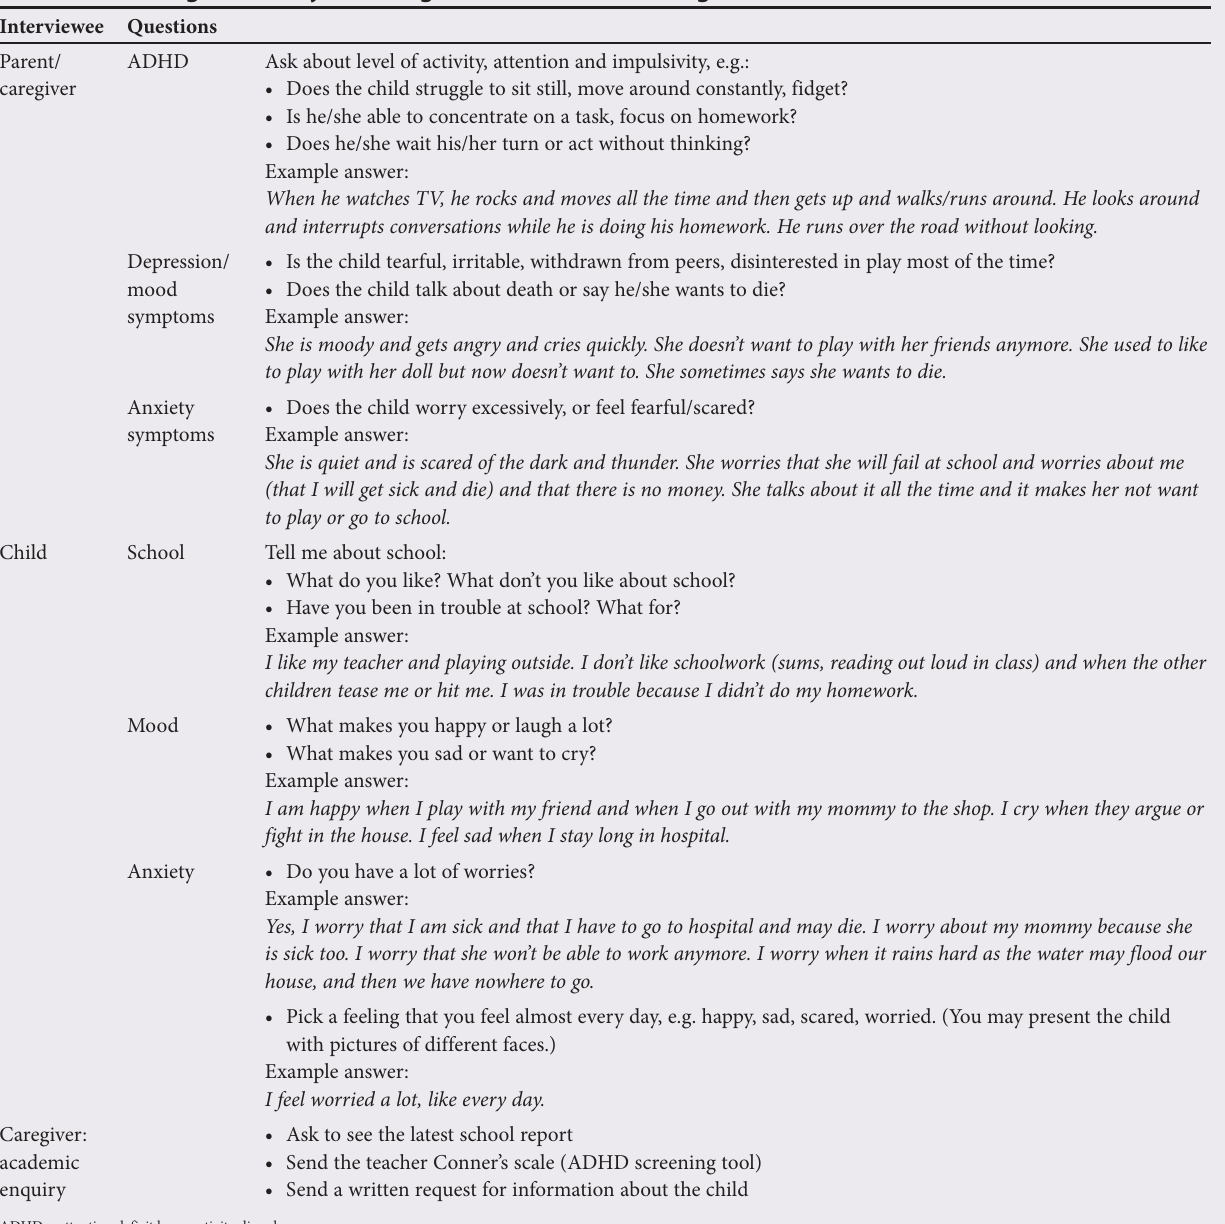
Table 2. Detecting commonly occurring mental disorders among HIV-infected children Interviewee